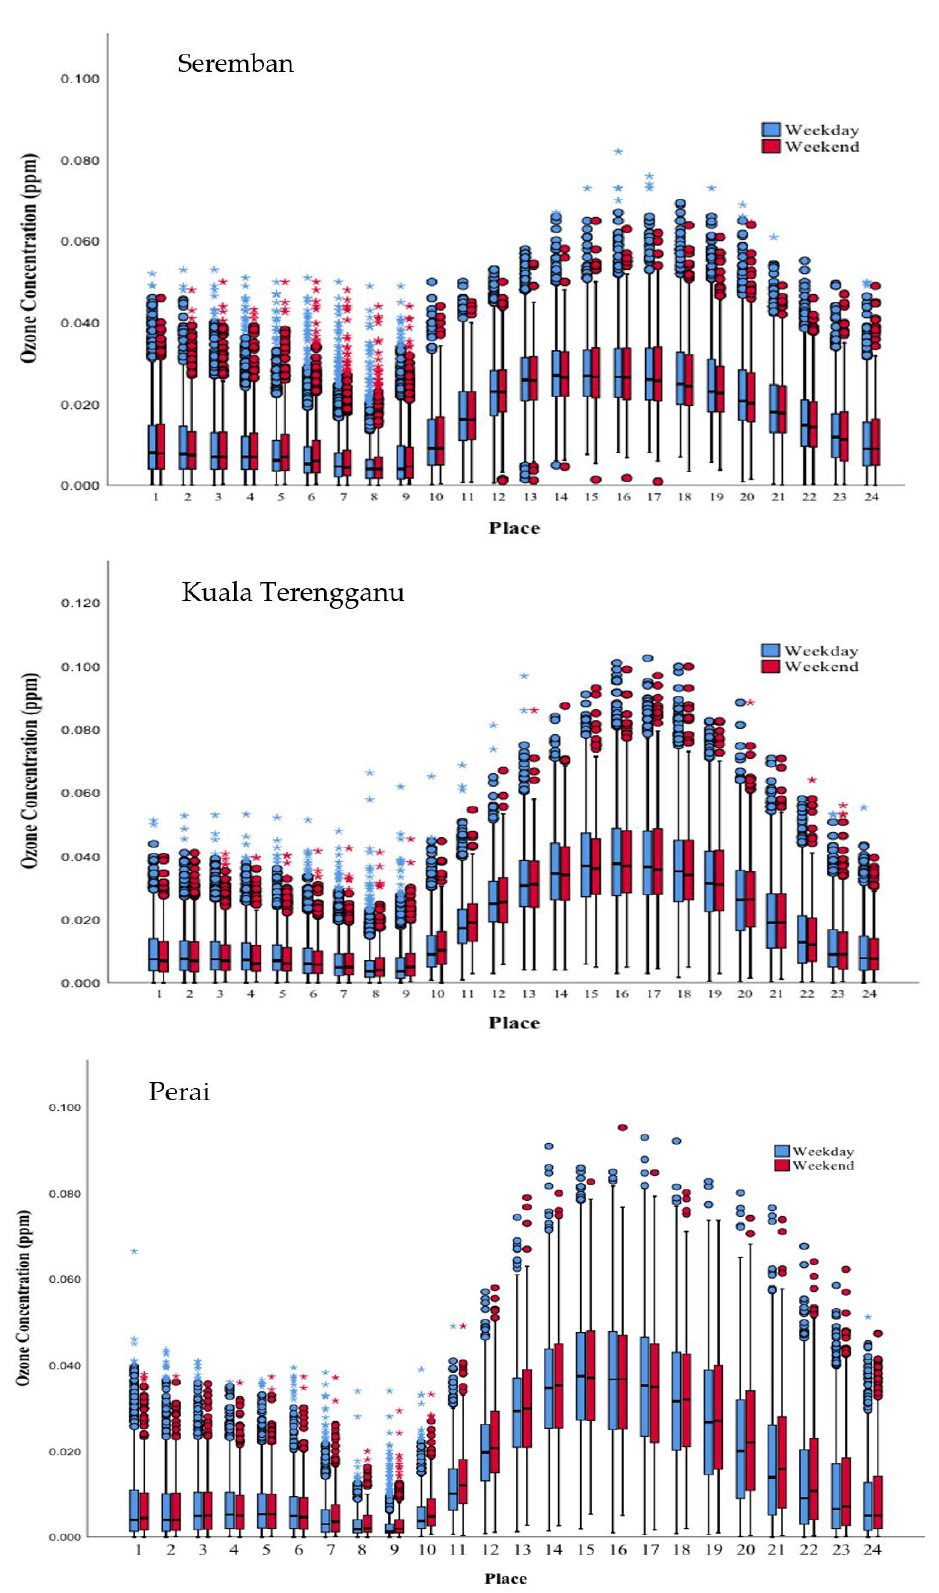
Figure 4. Diurnal plot of O 3 level during weekdays and weekends. The asterisk (*) on the boxplot indicate the extreme outlier that lie >1.5 times the size of the box.